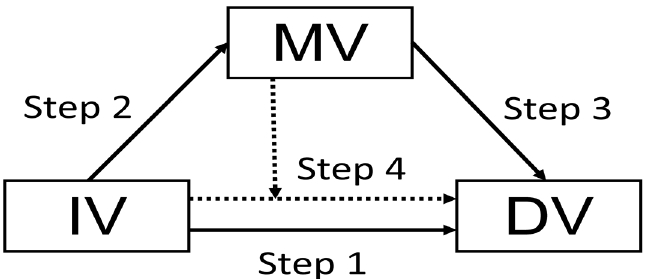
Fig 1. The scheme of testing procedure of mediating effects. IV: independent variable; MV: mediating variable; DV: dependent variable. Step 1: to test if IV predicts DV without including MV as a covariate; Step 2: to test if IV predicts MV; Step 3: to test if MV predicts DV; Step 4: to test if IV predicts DV with MV as a